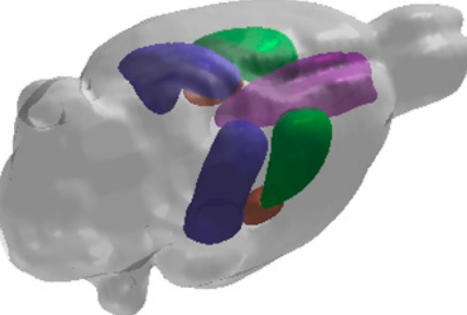
Figure 2. A representative 3D image of a rat brain which has been digitally reconstructed from magnetic resonance imaging (MRI) scans and depicts the medial prefrontal cortex (violet), caudate putamen (green), hippocampus (blue) and amygdala (brown).